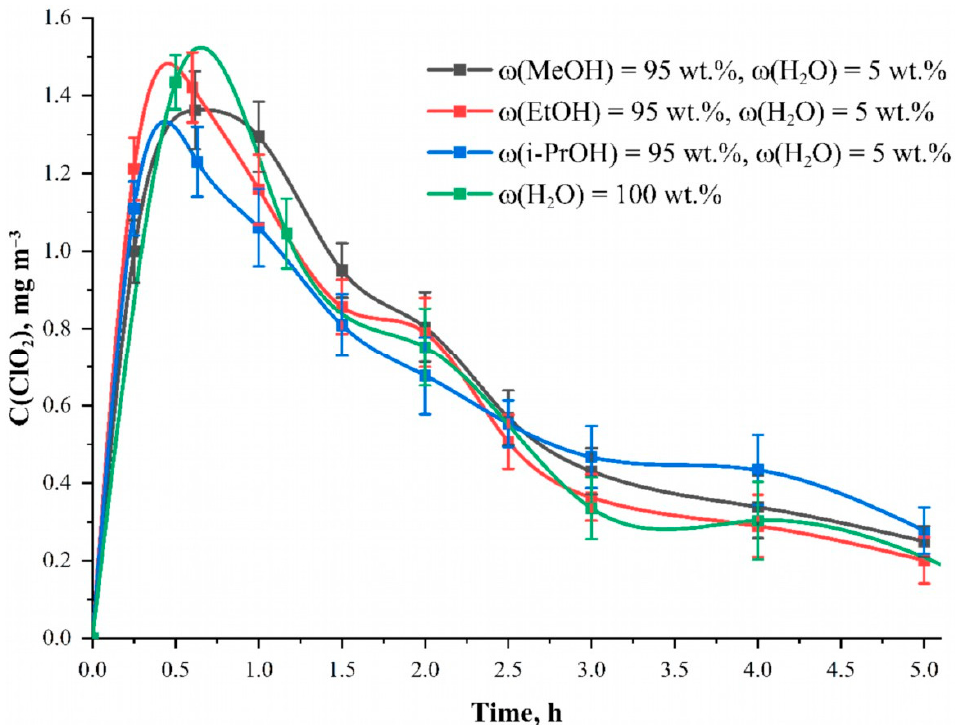
Figure 2. Dependencies of ClO 2 concentration inside the camera when applying NaClO 2 solution in different solvents onto the fabric surface at the time after the start of the reaction. Solution— C(NaClO 2 ) = 25.0 mmol L –1 , material—phosphorylated cotton cellulose fabric with the content of phosphorus-containing groups equal to 0.802 ± 0.082 mmol g –1 .